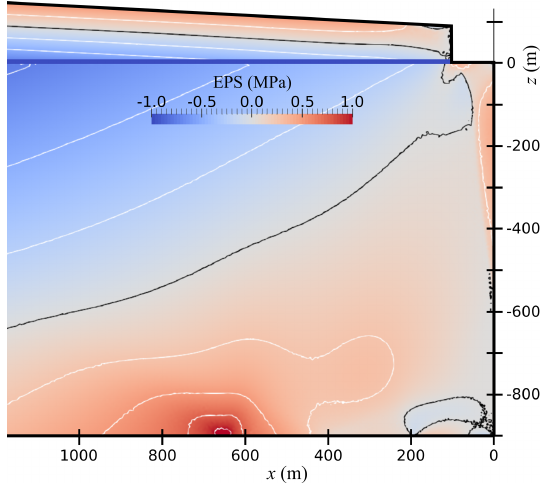
Figure 4. Effective principal stress map of the terminus of the glacier with a notch cut to a length l n = 100m, with contours at 0.1MPa spacing. d w = 900m, h t = 980m, α = 3 ◦ and C = 5 . 623 × 10 6 Pam − 1 / 3 s 1 / 3 . Ungrounding occurred between approx- imately 190 and 640m. The black contour denotes EPS = 0MPa; white contours are spaced at 0.25MPa